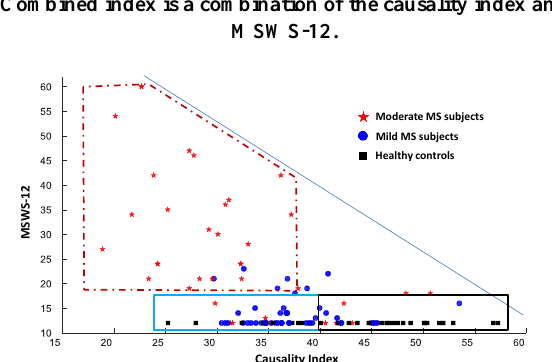
Figure 4. Analysis of effect size from one-way, within-subjects ANOVAs. The EDSS scores were used as the within-subjects factor with three levels (healthy, mild, and moderate).